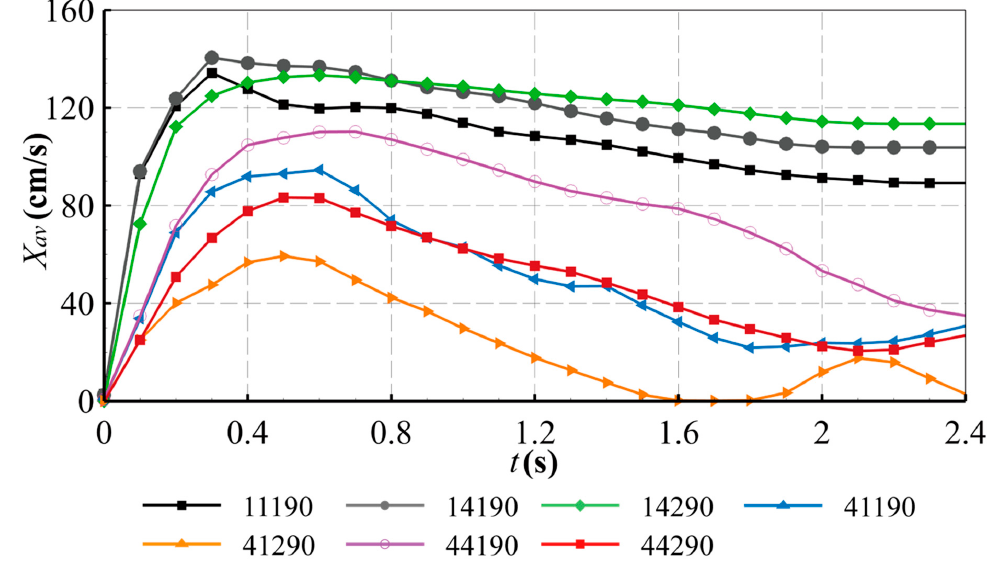
Figure 15. Three systematic comparisons of mean velocity among the container configuration group.